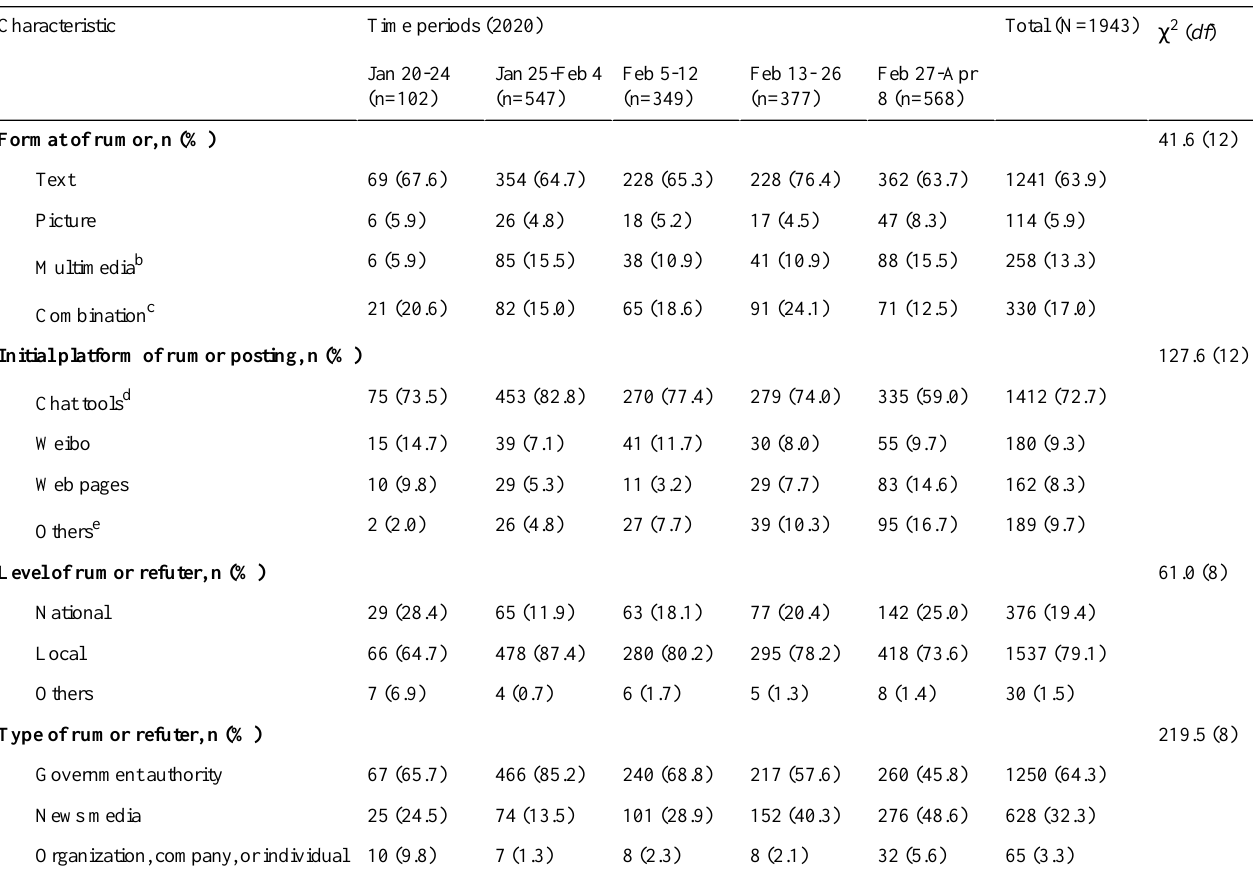
Table 2. Characteristics of rumors across five periods during the outbreak of COVID-19 in China (N=1943). a P <.001 for all categories.